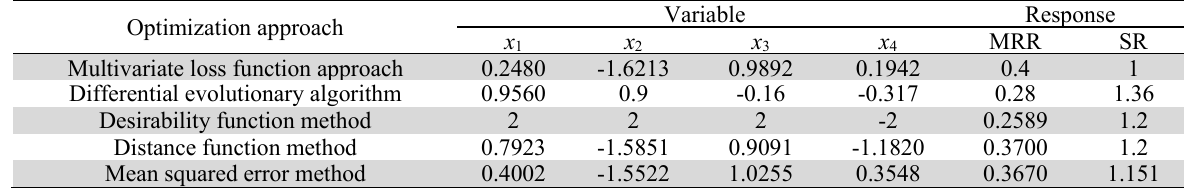
Comparison of the optimal parametric settings for ECM process Optimization approach